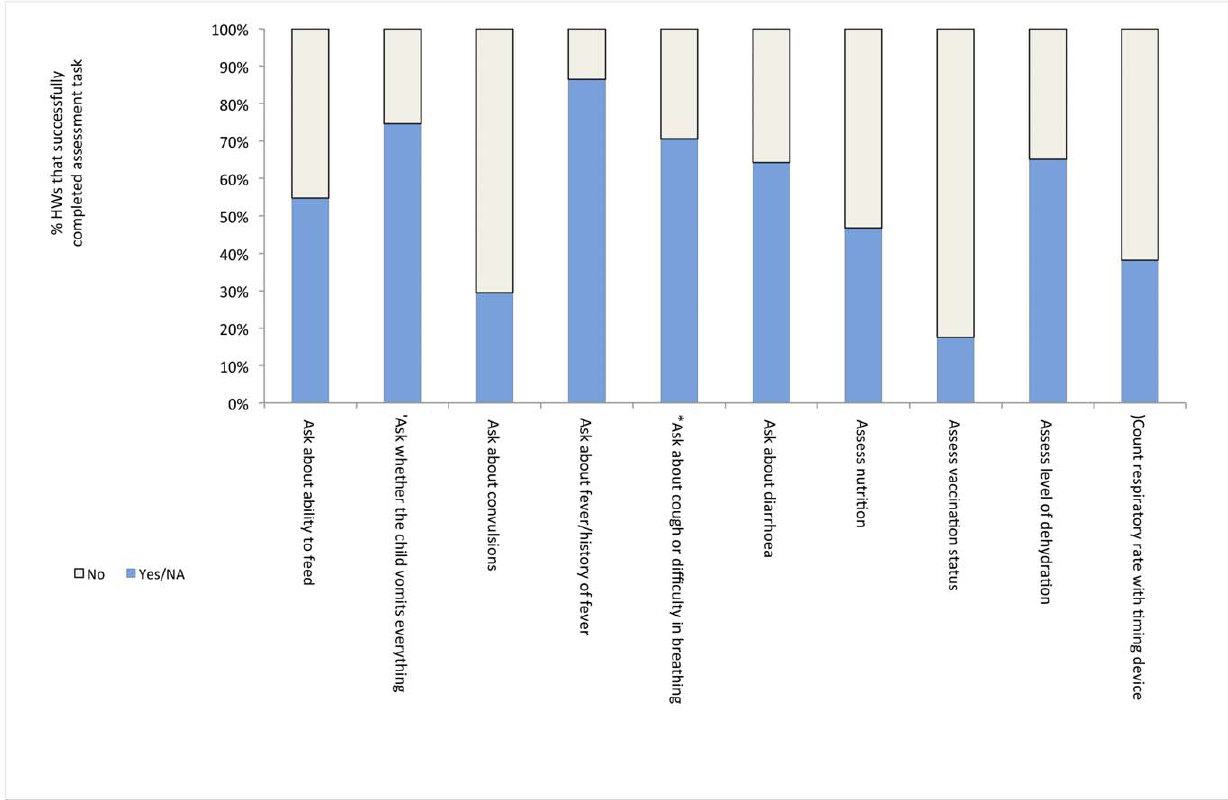
Figure 3. Percent of health workers in Jigawa carrying out IMCI assessment.